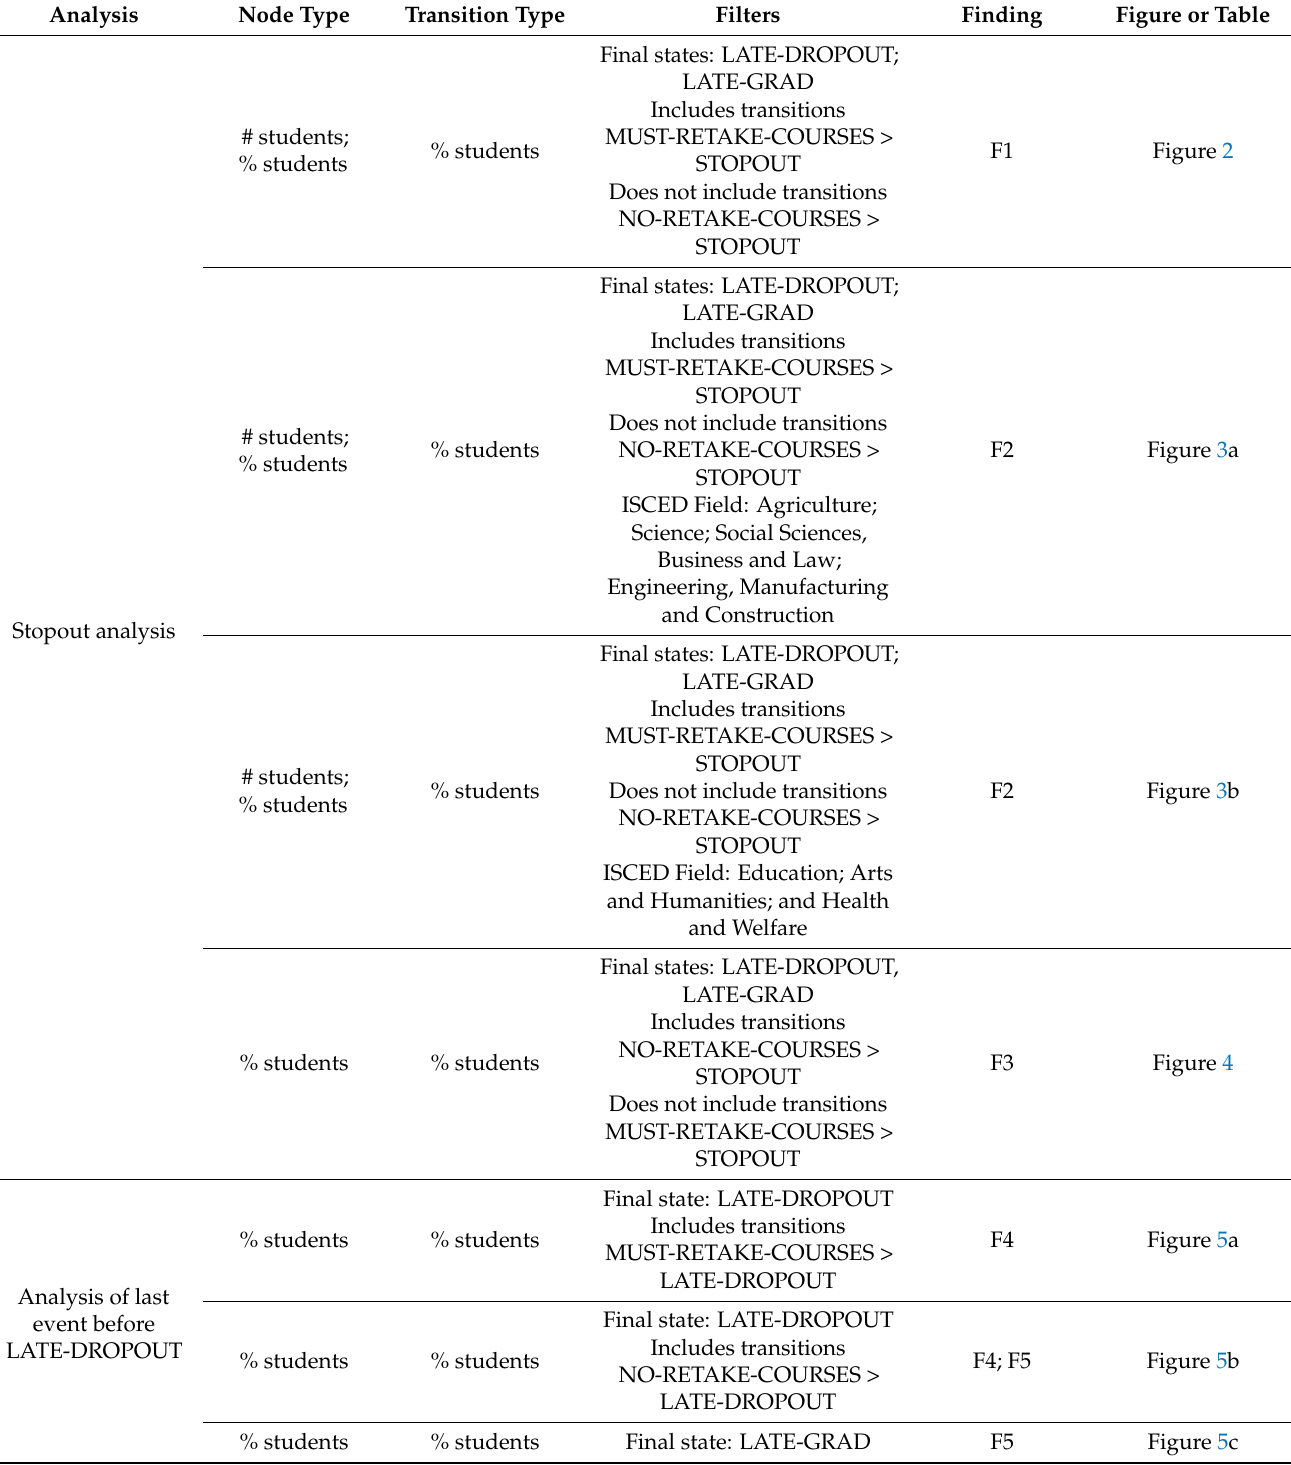
Table 4. Filters and properties applied to the event logs to perform each analysis for answering the research question.